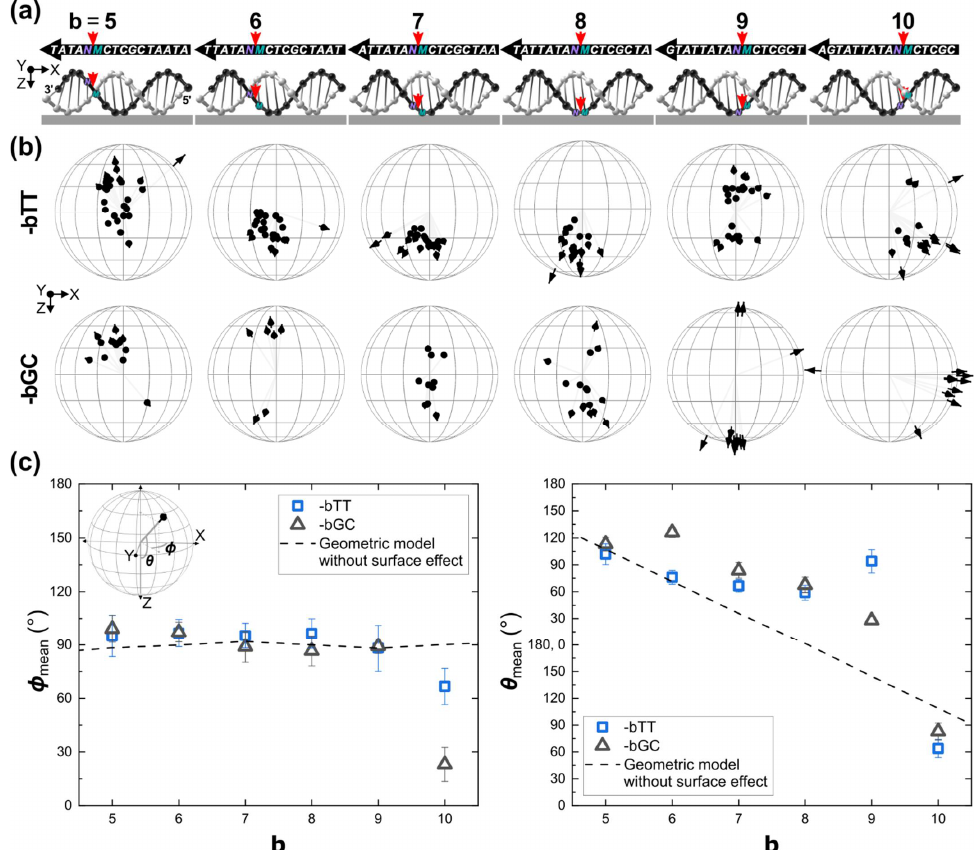
Figure 3. The effect of the glass surface on the spatial orientation of Cy5, as a function of the attachment position b . ( a ) Schematics of DNA duplex on the glass substrate indicating b locations used in the study. Samples are labeled as -bMN , where M and N were the dye’s flanking bases at the 5′ and 3′ ends, respectively. The negative sign indicates that the 5′-to-3′ direction of the Cy5-tethered strand runs along the negative X-axis (see Figure 1a). ( b ) Results for -bTT (top row) and -bGC (bottom row). Each column of spheres corresponds to the schematics in ( a ). Experimental orientations are plotted on the unit hemisphere as black arrows. ( c ) Plots of ϕ mean vs. b and θ mean vs b . The inset on the left shows again the coordinates for convenience. A geometric model (dash lines) was con- structed based on the neighboring base pairs in a static DNA duplex without any effect from the surface (see Text S4.1). Error bars are (cid:2026) = ±(cid:3493)(cid:2026) (cid:3051)∗ (cid:2026) (cid:3052)∗ , where (cid:2026) (cid:3051)∗ and (cid:2026) (cid:3052)∗ are the standard deviations of the elliptical cone with the center in the mean direction in the framework of the Kent (Fisher- Bingham) distribution [59].